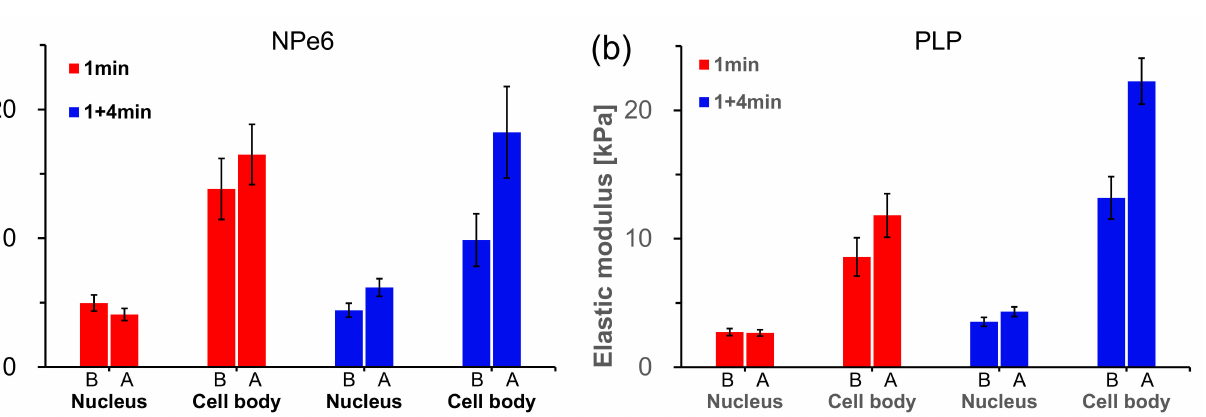
Figure 7. Estimated average local elastic moduli around the cell nucleus and the edge of the cell (referred to cell body) over all observed cells. N = 44 (1 min) and 45 (1 min + 4 min) for NPe6 ( a ), and 34 (1 min), and 26 (1 min + 4 min) for PLP ( b ),